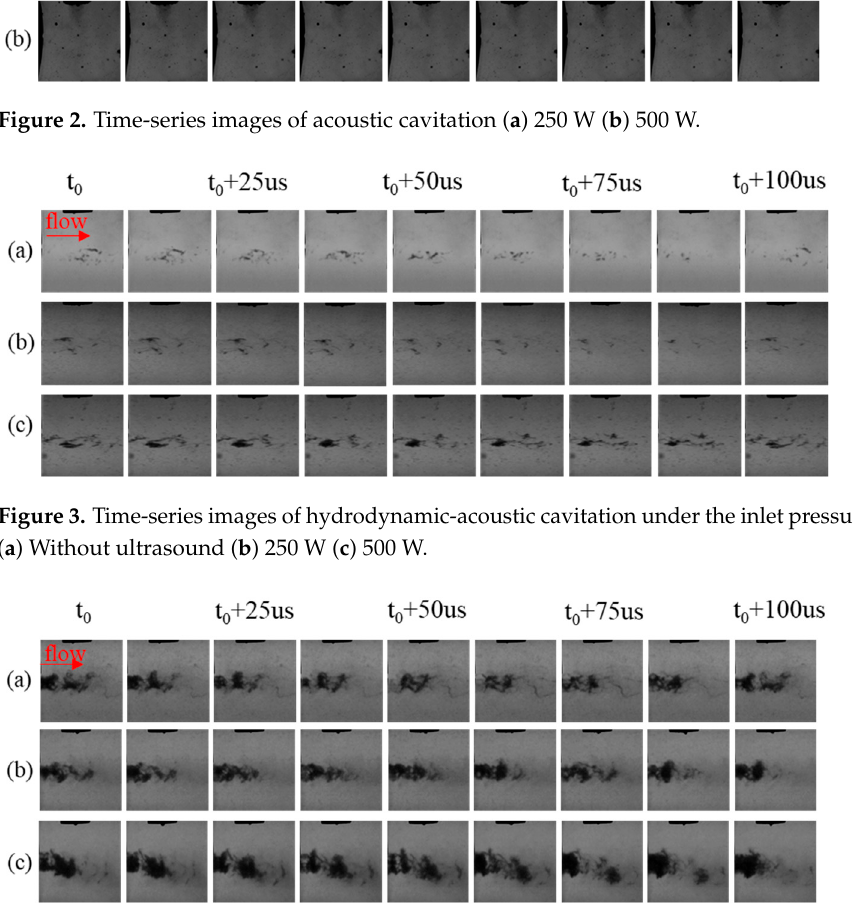
Figure 4. Time-series images of hydrodynamic-acoustic cavitation under the inlet pressure of 2 MPa ( a ) Without ultrasound ( b ) 250 W ( c ) 500 W. ( a ) Without ultrasound ( b ) 250 W ( c ) 500